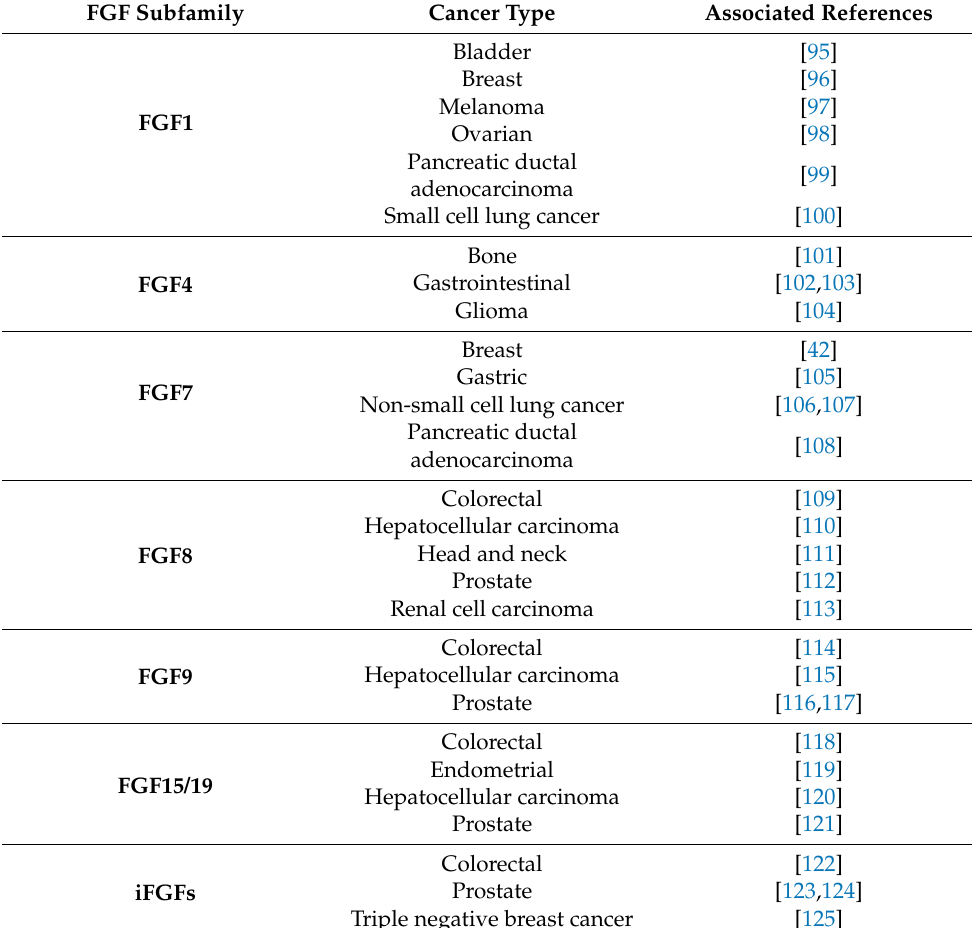
FGF, fibroblast growth factor; iFGFs, intracellular